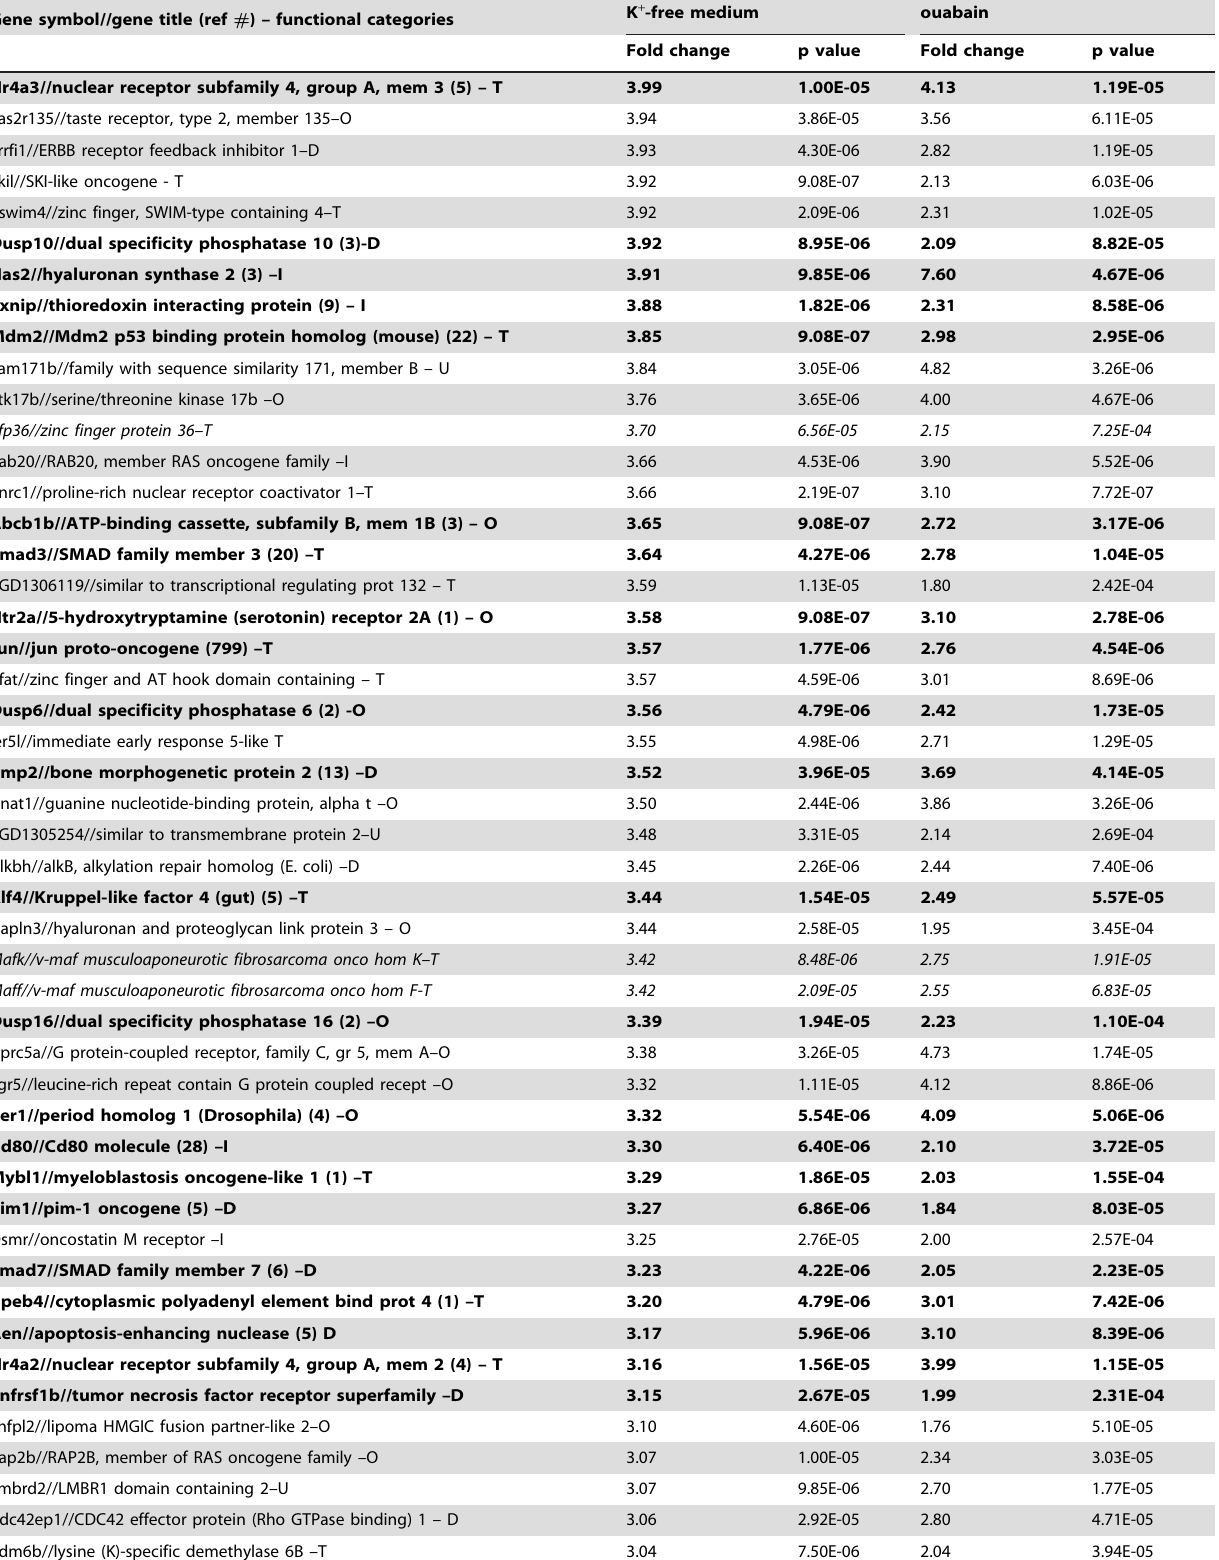
Gene symbol//gene title (ref # ) – functional